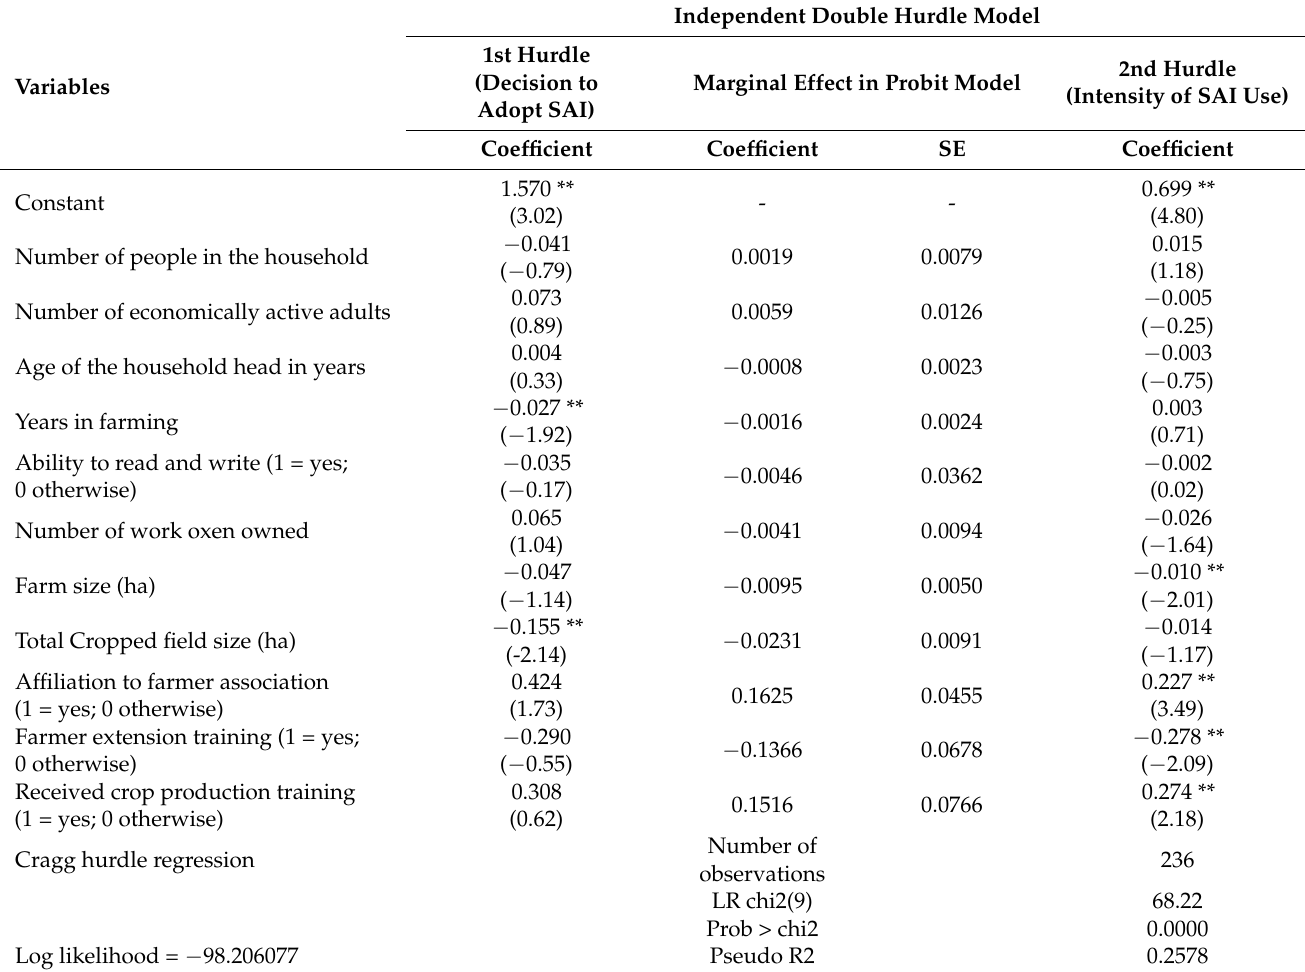
Table 3. Estimated double hurdle model for factors influencing the adoption of SAI and intensity of use in Katete district,